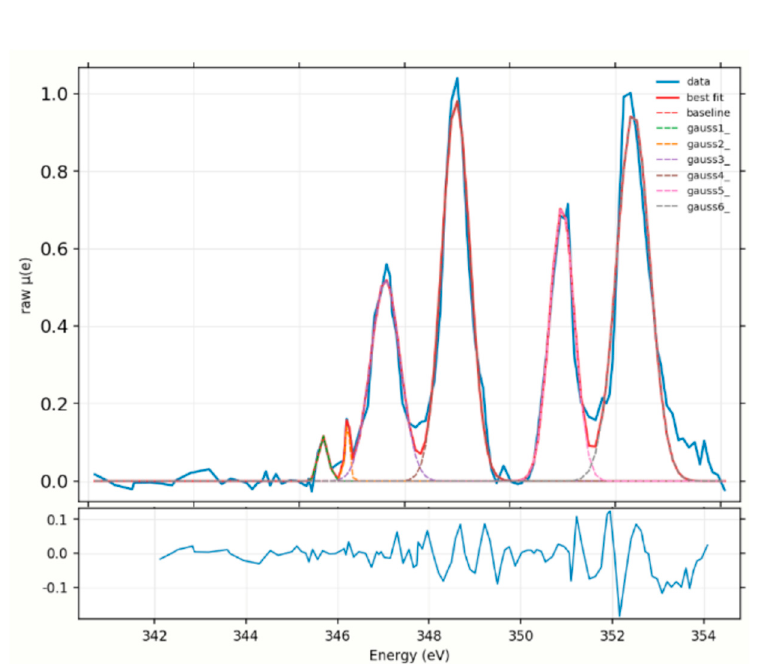
Figure 8. Gaussian peaks fit shown for a typical measured calcite spectrum. The number of fitted peaks is six and they have similar FWHM. The fit result was used to calculate the data reported in Figure 7a,c as explained in the corresponding methods sections. The residual, calculated simply as the difference between the fit and the experimental data, is also reported in the inset below the fit.